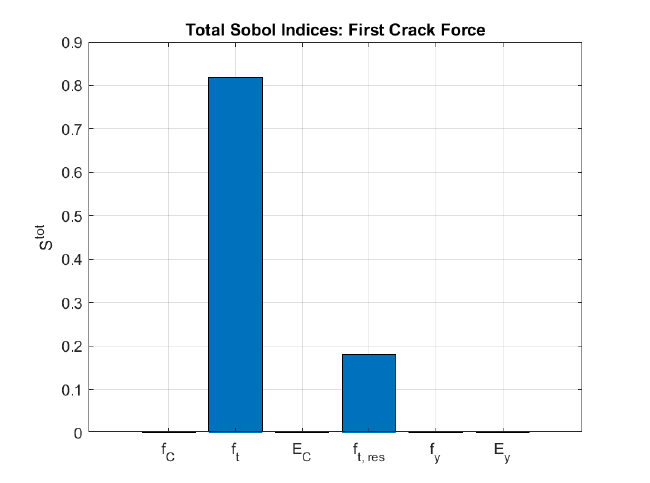
Figure 14. Total Sobol’ indices for first-crack